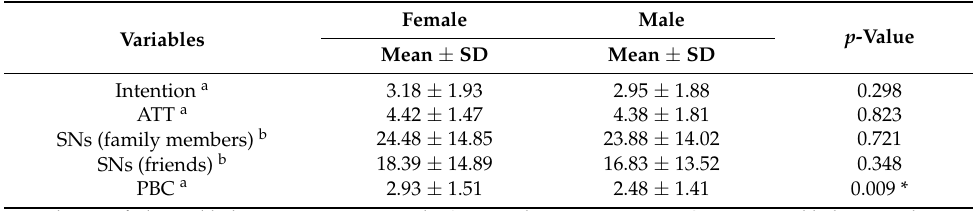
Table 2. Mean, SD for TPB variables.